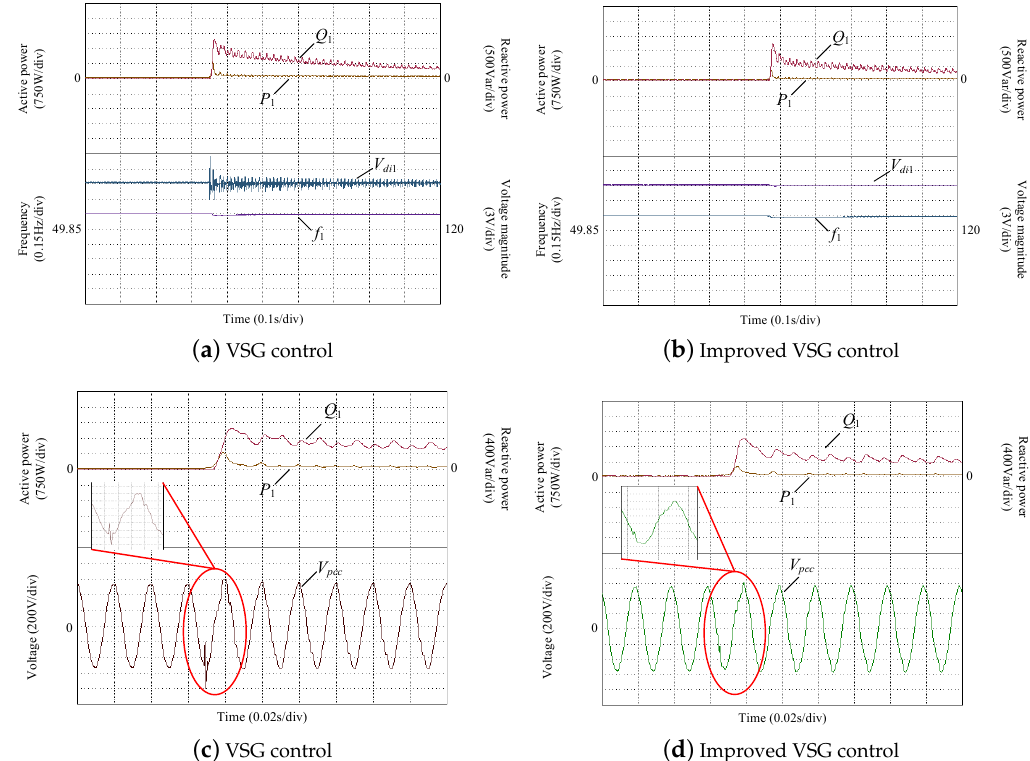
Figure 6. Waveforms of microgrid when transformer load is